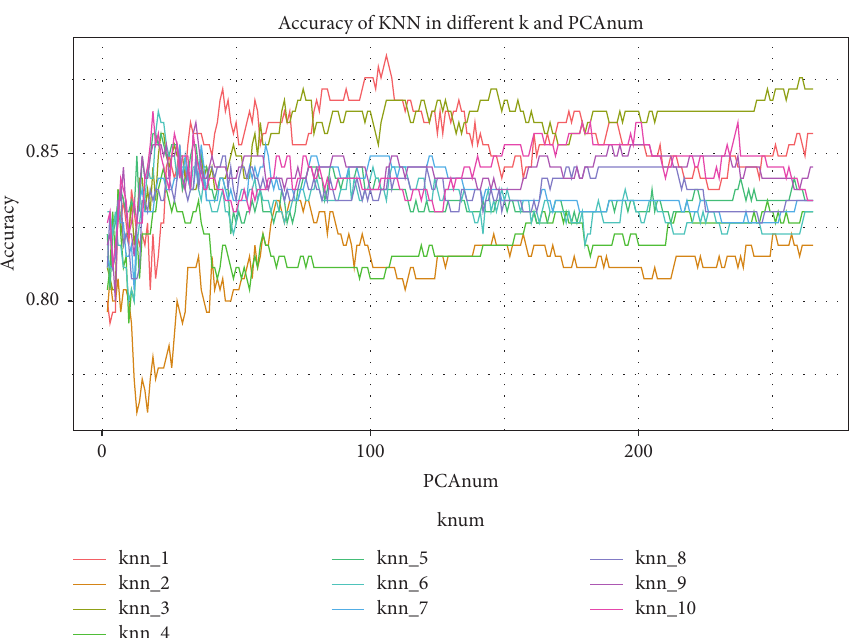
Figure 10: Comparison of correct rate of KNN optimization